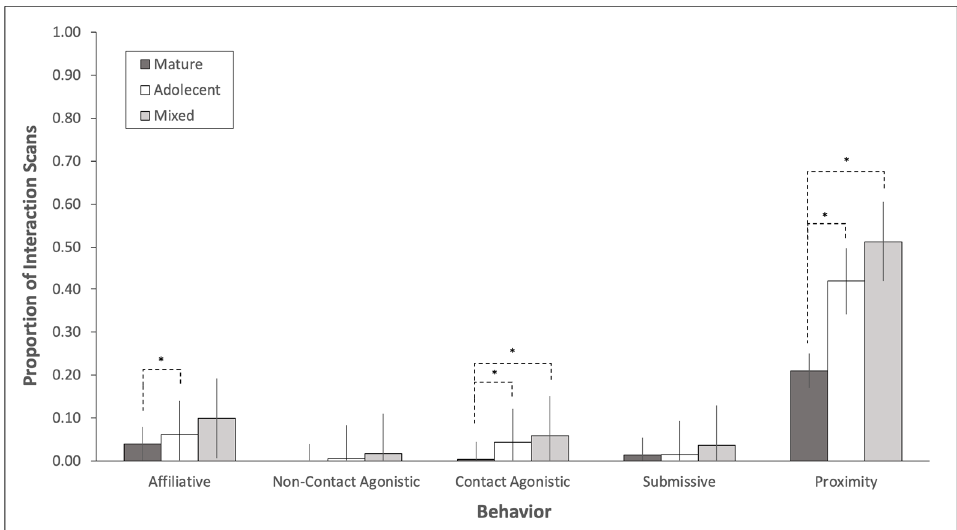
Figure 2. Proportion of scans when a mature focal animal engaged in social behaviors in different social groups. Mature bulls exhibited significantly more affiliative behavior when they were housed with only adolescent bulls compared to when they were with only other mature bulls. Mature elephants engaged in more contact agonistic behavior and spent significantly more time in proximity to a conspecific in social groups that included only adolescent bulls and in mixed-age social groups compared to when they were housed with only the other mature bull. Mature = mature focal animal housed with group including only the other bull who regularly underwent musth; Adolescent = mature focal animal housed with group including only bulls who do not regularly undergo musth; Mixed = mature focal animal housed with group including both bulls who do and do not regularly undergo musth. * indicates p < 0.05.